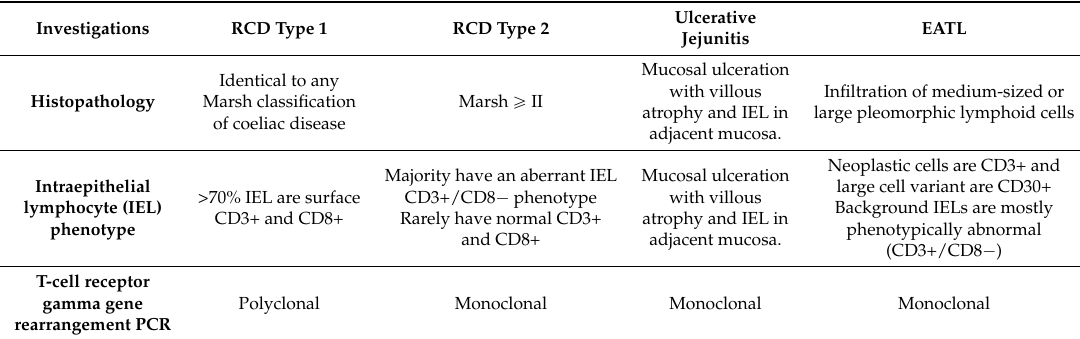
Table 1. Comparison between refractory coeliac disease (RCD) type 1, RCD type 2, ulcerative jejunitis and enteropathy associated T-cell lymphoma